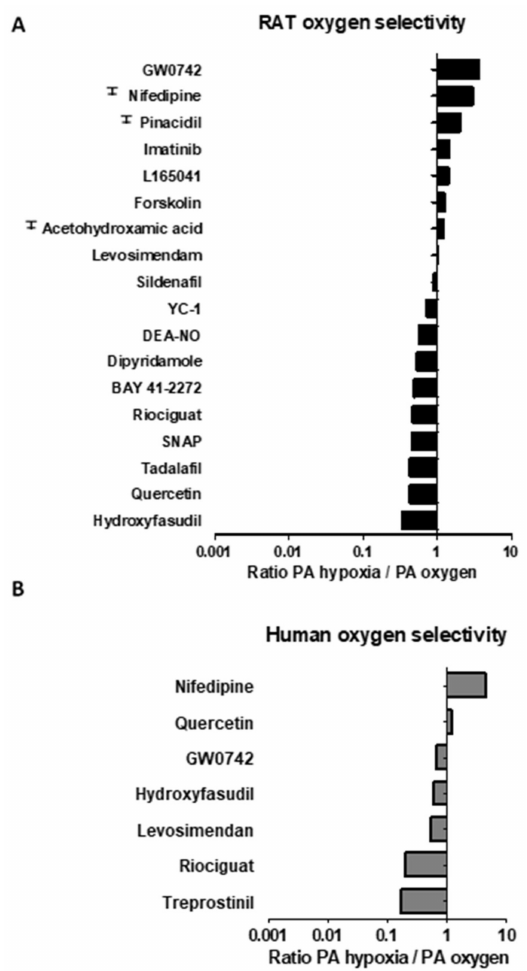
Figure 3. Relative oxygen selectivity of different vasodilator drugs in rat ( A ) and human ( B ) PA. Figure 2. Selectivity of drugs for pulmonary vessels. Relative pulmonary selectivity of different Data are expressed as relative potency (pIC 50 ) in PA under conditions of high vs. low oxygenation, vasodilator drugs in rat arteries. Data are expressed as relative potency (pIC 50 ) in MA vs PA under high oxygenation. Ŧ indicates that data are expressed as relative pIC 30 values in MA vs PA. Values respectively. indicates that data are expressed as relative pIC 30 values in PA under high vs. low > 1 indicate greater selectivity for PA oxygen; while values < 1 indicate greater selectivity for MA oxygenation. Values > 1 indicate selectivity for PA oxygen; while values < 1 indicate selectivity for oxygen. PA